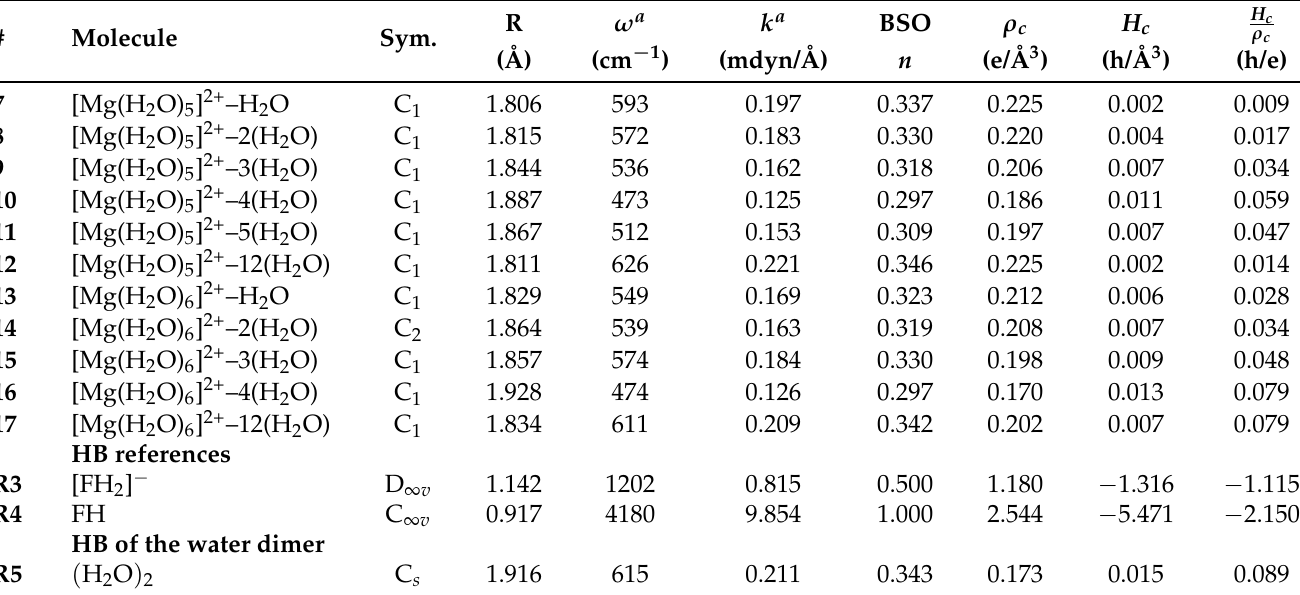
Table 2. Bond distances (R), local mode frequencies ( ω a ), local mode force constants ( k a ), bond strength orders (BSO n ), electron densities ( ρ c ), energy densities ( H c ), and the energy density ratios ( H c 7 – 17 and reference molecules R3 – R5 , calculated at the ω B97X-D/6-311++G(d,p) level of theory a